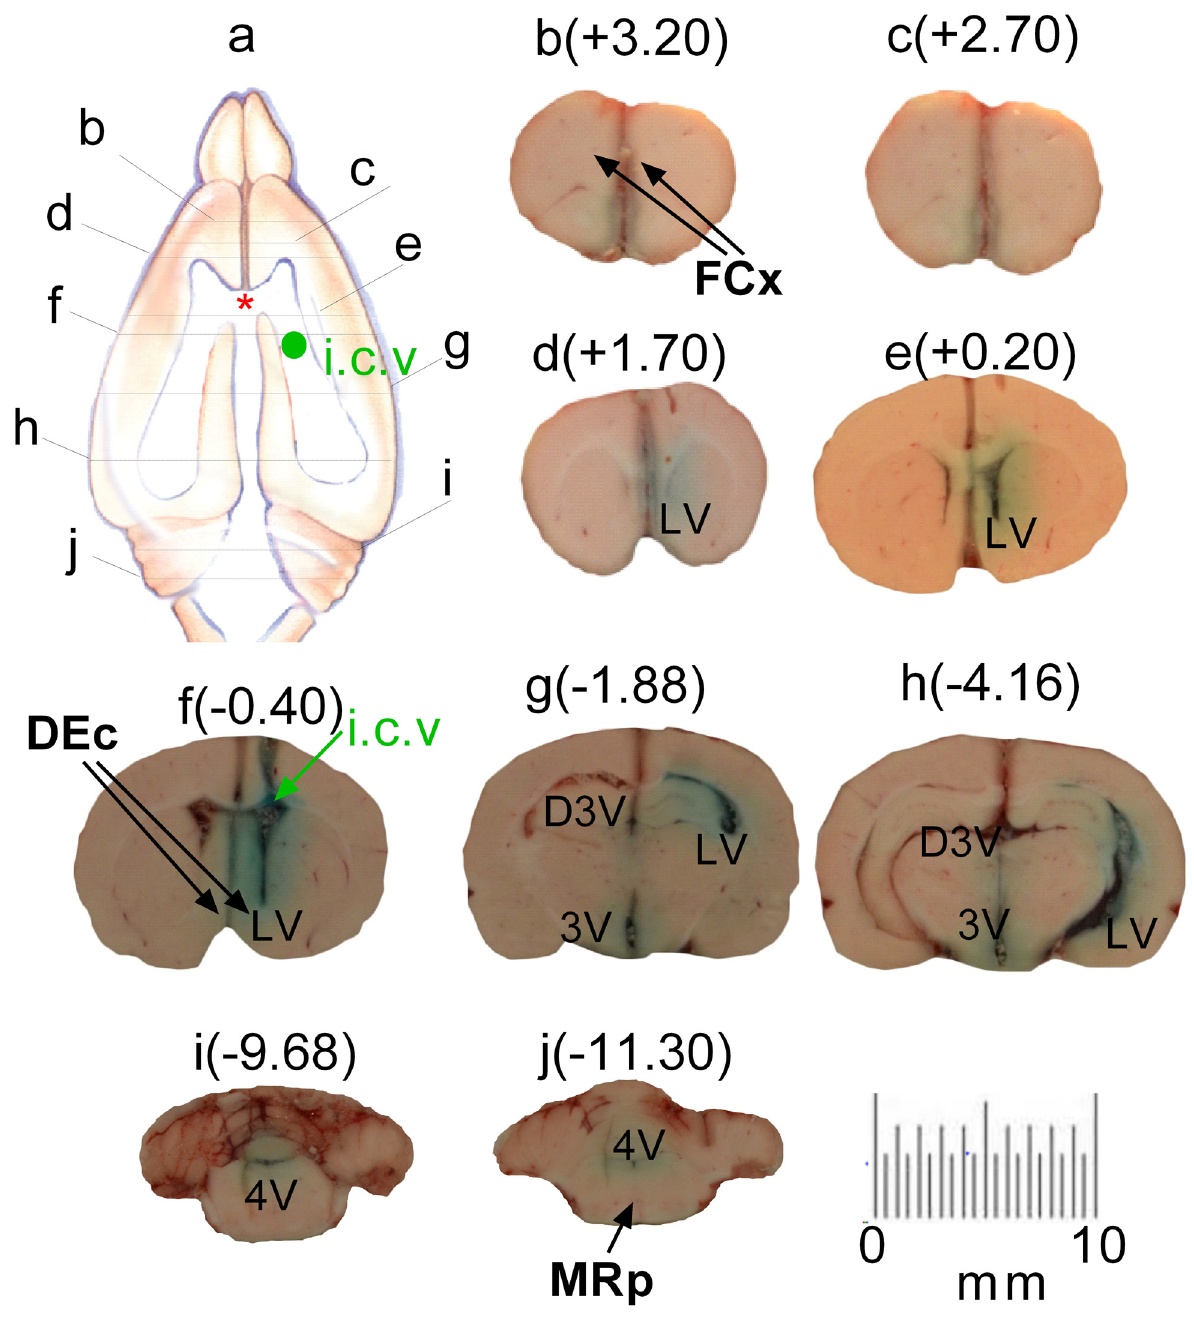
Fig 9. Relationship between intracranial administration and dye diffusion from the delivery site to the surrounding or distant tissue. The route of intracranial administration was ICV. The dyes used in this test were fast green. N = 5 rats. a, Diagram represents the atlas anterior or posterior to the bregma ( * ). Lines indicate where the section was cut. After ICV administration to the right LV (f), fast green was distributed within four ventricles, including the ipsilateral LV (d, e, f, g and h), 3V (g, h) and 4V (I, j), but poorly in the contralateral LV. Diffusion of fast green to the ISF was poor, ~1.5 – 2 mm away from the ventricle compartments. However, there was no fast green in the FCx (b,